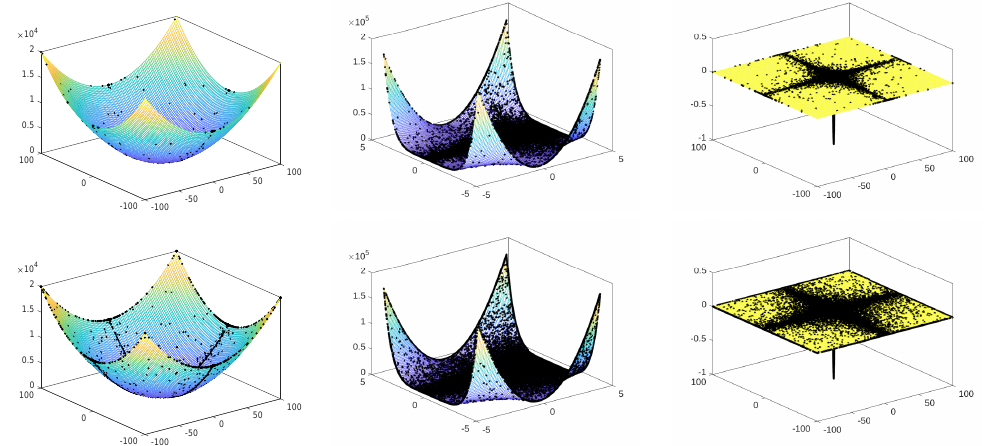
Figure 5. Obtained solutions in the search space of functions f 1 , f 3 , and f 4 ; by the ESCA algorithm ( first row ); and the SCA algorithm ( second row